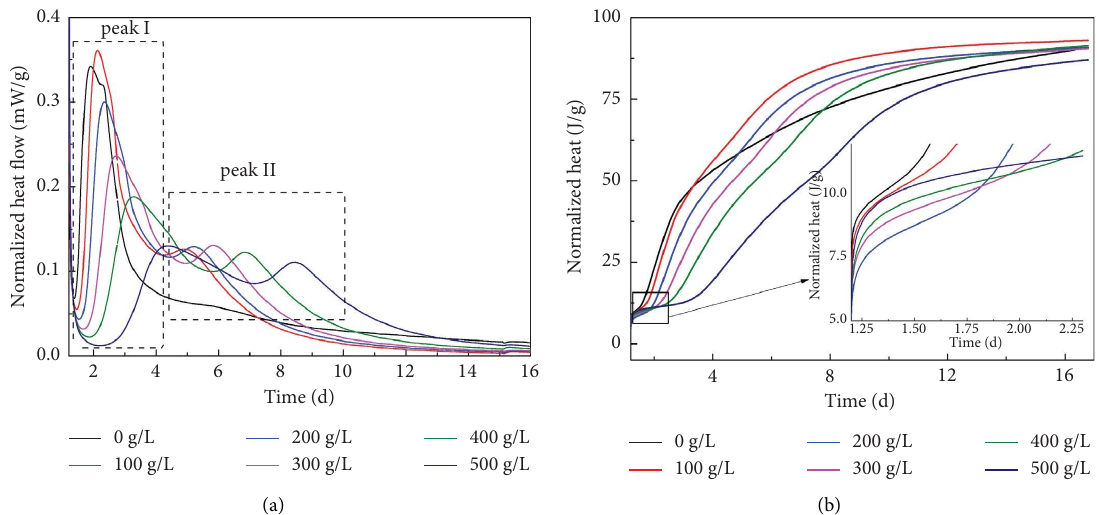
Figure 1: Te hydration exothermic curves of the SFCM with diferent sodium nitrate concentrations at 20 ° C: (a) normalized heat fow; (b) normalized heat.